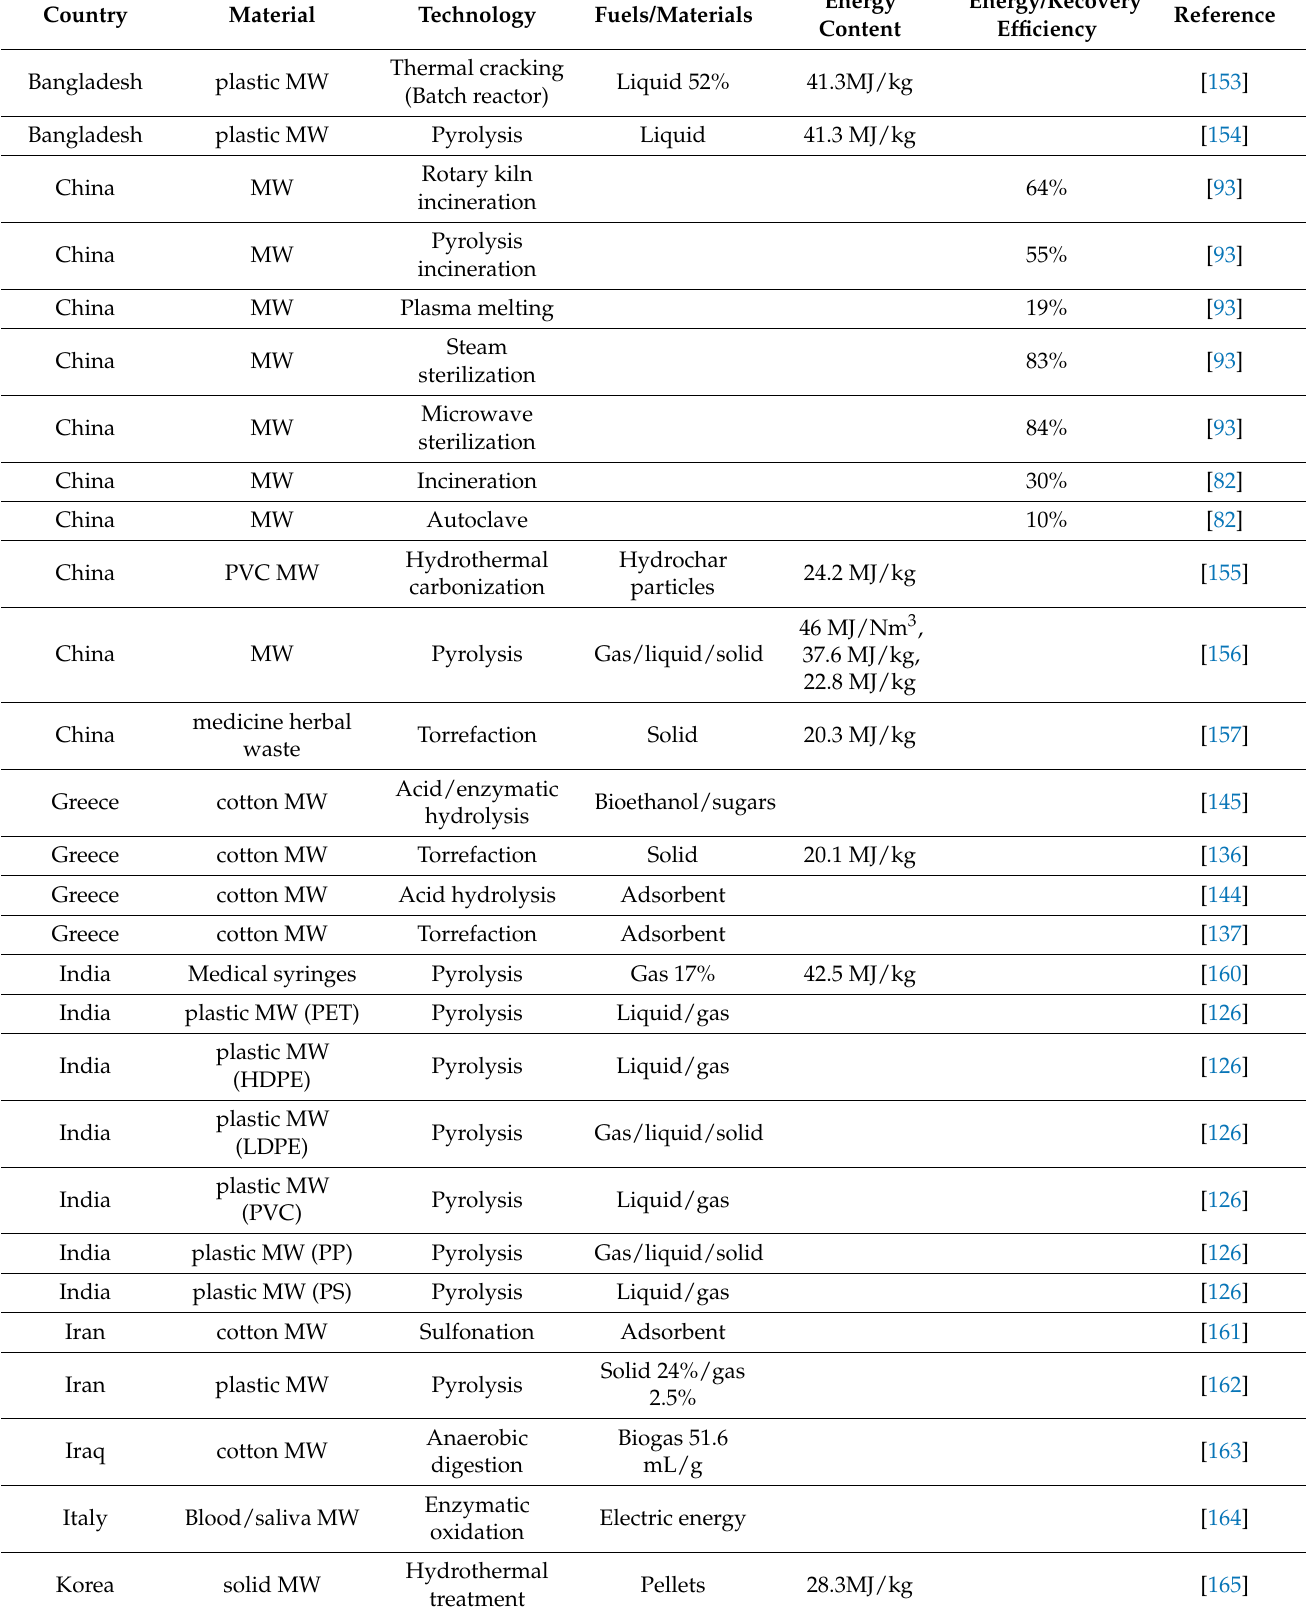
Table 4. Medical waste (MW) treatment technologies and energy/fuels/materials production.